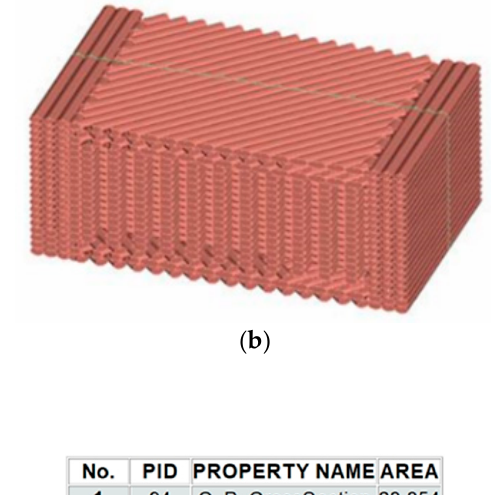
Figure 3. Cross-section distance from the edge of the tensile specimen.